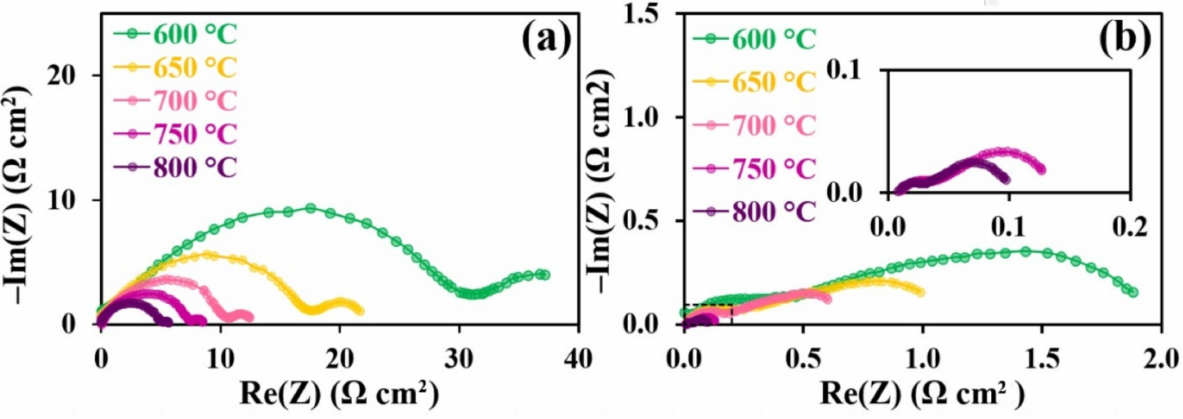
Figure 7. Electrochemical data obtained fothe PNF|BCZY|PNF ( a ) and PNC|BCZY|PNC ( b ) sym- metrical